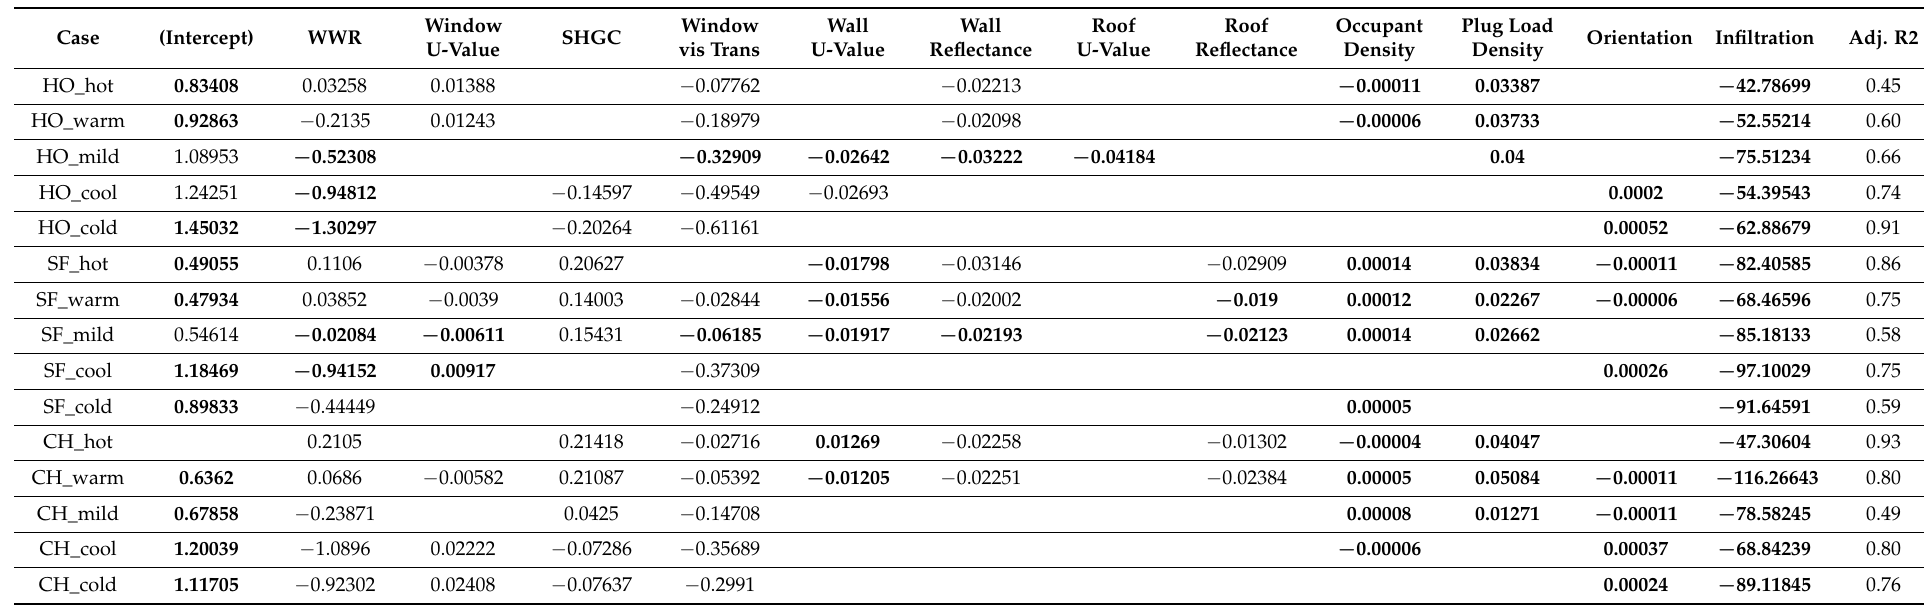
Table A1. Overall OHL Regression results.